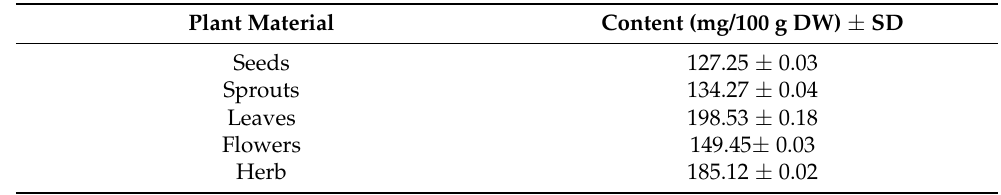
Table 2. Average content of rosmarinic acid (mg/100 g DW ± SD) performed by HPLC-DAD analysis in seed, sprout, leaf, flower and herb extracts of S. hispanica